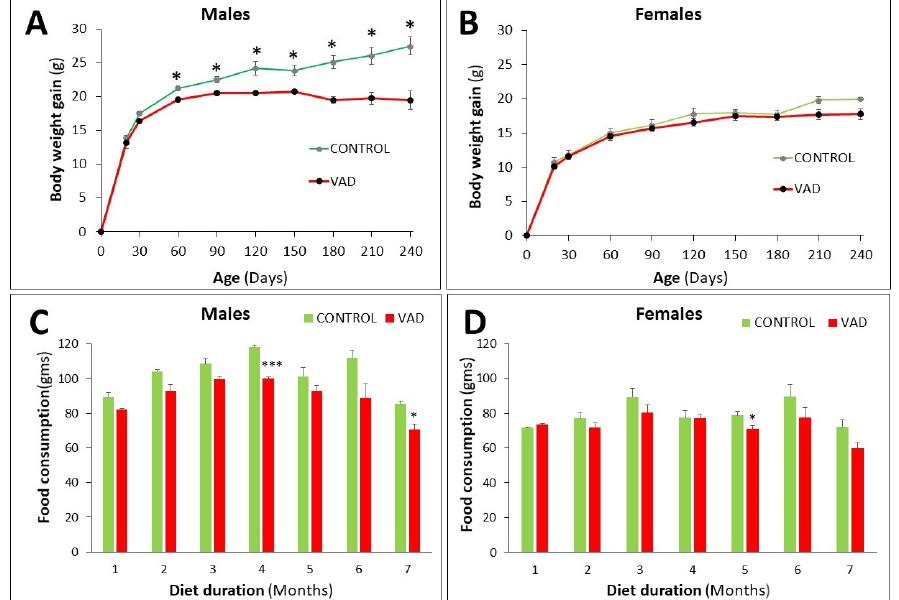
Figure 2. Weight gain ( A , B ) and food consumption ( C , D ) in control and VAD 8-month mice. Monthly changes are recorded separately in male ( n = 6) and female ( n = 12) mice. Each timepoint represents the mean ± SE. The asterisks indicate the significance of the difference between control and VAD, * p < 0.05, *** p < 0.001. Changes in food consumption in control mice showed a trend similar to that of their body weight gain. Males consumed more food than females (Figure 2C,D). In VAD mice, food consumption was reduced in males when compared to their control littermates and the difference was statistically significant only at 4 and 7 months, p = 0.0006 and 0.025, respectively (Figure 2C). In female VAD mice, the reduction in food consumption was only significant at 5 months, p = 0.045 (Figure 2D). 3.2. Anatomical and Histological Alterations of VAD Stomachs Gross morphological examination of the stomachs of 4-month-VAD mice showed no difference when compared with their control littermates. However, microscopic examina- tion of the stomach tissue sections of the 4-month VAD mice stained with H&E or PAS showed a few mild glandular dilatations in the cardiac region near the limiting ridge when compared to their control littermates (Figure S1A). By 8 months, the VAD mice developed a strikingly enlarged forestomach at the ex- pense of the glandular region (Figure 3A). In addition, the limiting ridge between the forestomach and the cardia was more prominent in VAD mice than in their control litter- mates. These observations were more evident in male than female VAD mice (Figure S1A). Microscopically, the 8-month VAD mice were characterized by overgrowth and folding of the limiting ridge over the glandular cardia and corpus (Figure 3B,C). This overgrowth was associated with the enlargement of dilated glandular structures at the limiting ridge